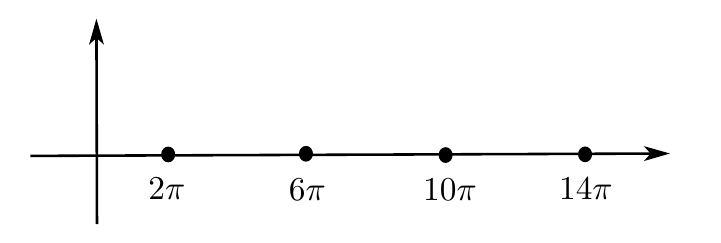
Figure 4: The very first singularities of the Borel transform of Φ ( z ) on the positive real